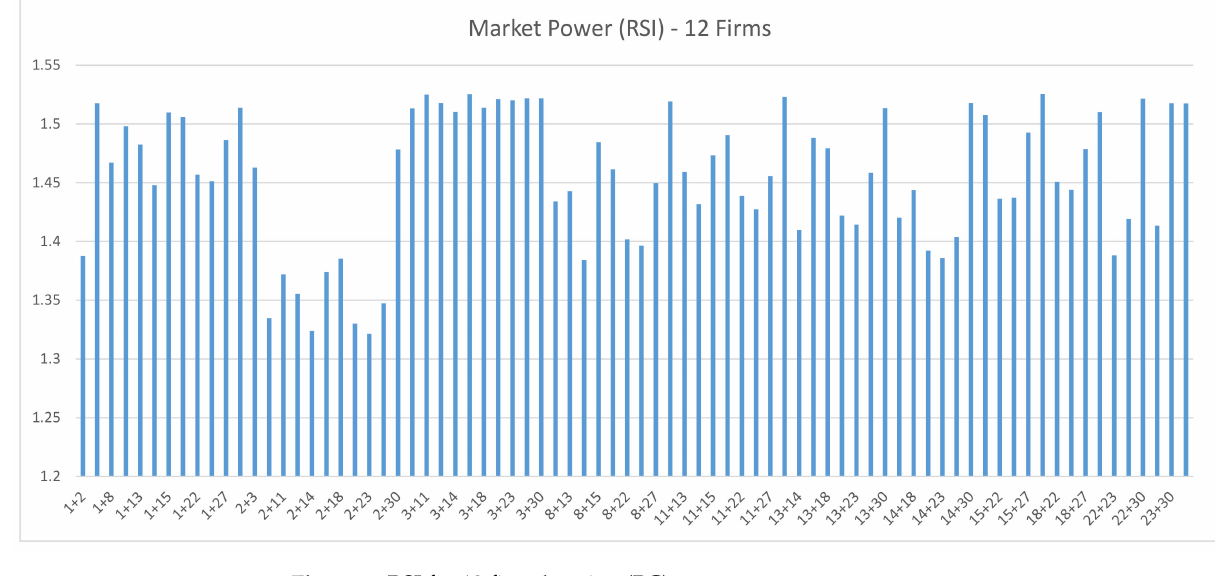
Figure 5. RSI for 12 firms’ setting (PC).